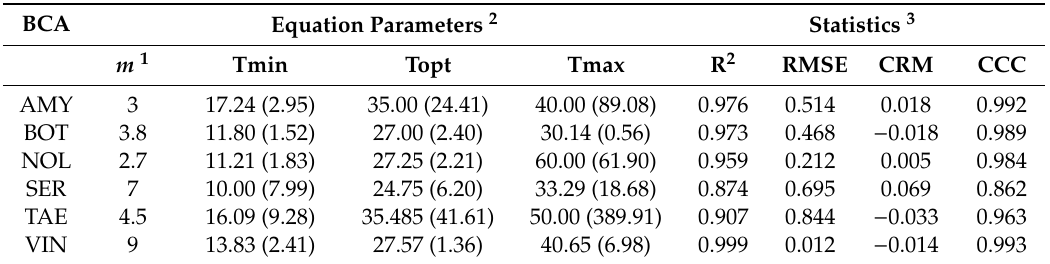
Table 3. Parameters of Equation (5) for the six BCAs, and statistics for goodness-of-fit to real data.